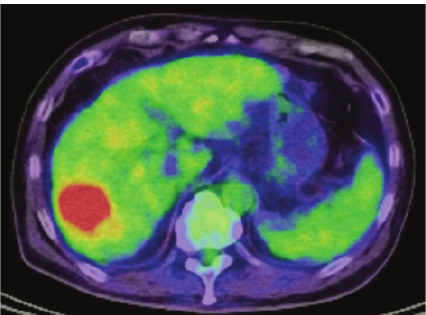
Figure 4: Positron emission tomography- (PET-) CT. Fluorine-18 fluorodeoxyglucose positron emission tomography (FDG-PET) shows abnormal uptake in segmental 6. The arrowhead denotes abnormal uptake